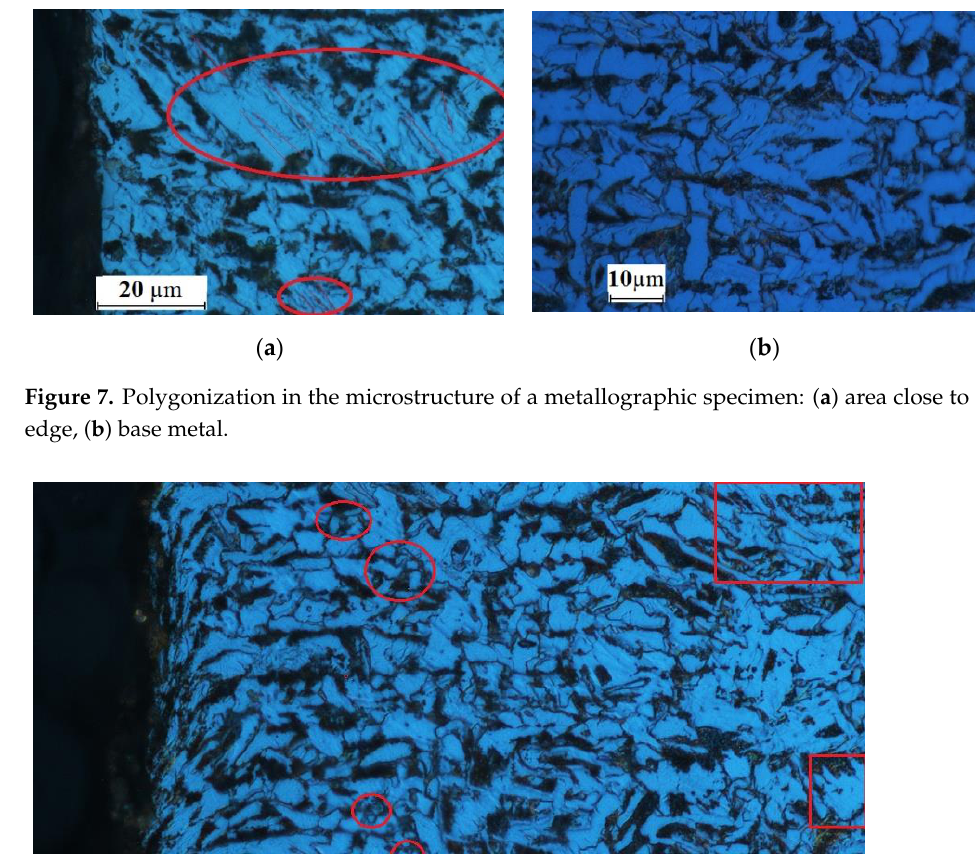
Figure 9. Recrystallization (red circles and yellow circles — at the cutting edge) in the microstruc- ture of a metallographic specimen. The heat transfer taking place at a sufficiently high temperature for a sufficiently long time causes the structure to become fine-grained in the whole volume. The effect is visible at close distances of up to 150 µm from the edge. The zone where the micro- structure changes occur is narrow because the heating and cooling times are short. It can be assumed that when materials thicker than 15 mm are cut, changes may be observed at larger distances. Nanohardness measurements were conducted to determine the effect of the cutting temperature on the material hardness. The measurements were taken along the edge of the specimens cut and prepared for metallographic analysis by polishing and etching. Five measurements were performed for each specimen at a load of 10 mN. The red colour in Figure 10 indicates the places where the nanoindentations were made in the material.